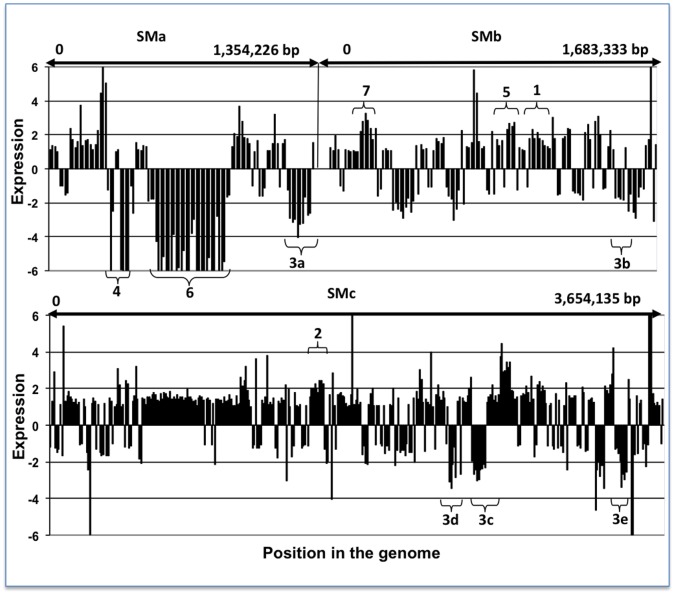
Expression profile of Rm1021 genes under low vs. high nitrogen.The expression ratio of the 609 genes identified in the study as either nitrogen stress responsive (Cluster I and II) and/or affected by mutations in the GlnD/GlnBK regulatory cascade (Cluster III). 1– wgeA, wgdB, wgdA, wggR, and wgcA; 2– aap operon; 3a – rhs, rhb, and rhr region; 3b – SMb21429, SMb21430, SMb21431, SMb21432– Putative iron ABC transporter; 3c – hmu region; 3d – SMc01657, SMc01658, SMc01659; 4– nosR/Z, nnrU – denitrification regulator protein; 5– pho region; 6– fixN region; 7– carbon fixation.